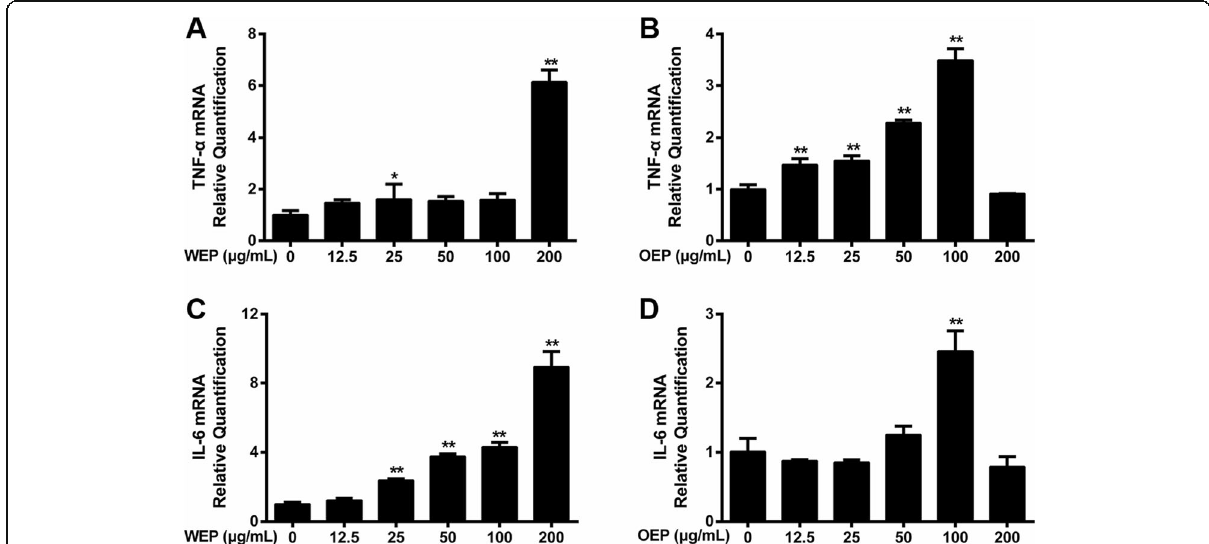
Fig. 4 Effects of PM 2.5 extracts on the mRNA expression of inflammatory cytokines in RAW264.7 cells. After 18 h, mRNA expression of ( a ) TNF- α and ( b ) IL-6 in WEP (200 μ g/mL)-treated RAW264.7 cells and of ( c ) TNF- α and (d) IL-6 in OEP (100 μ g/mL)-treated RAW264.7 cells. * < 0.05, ** < 0.01 vs. control.